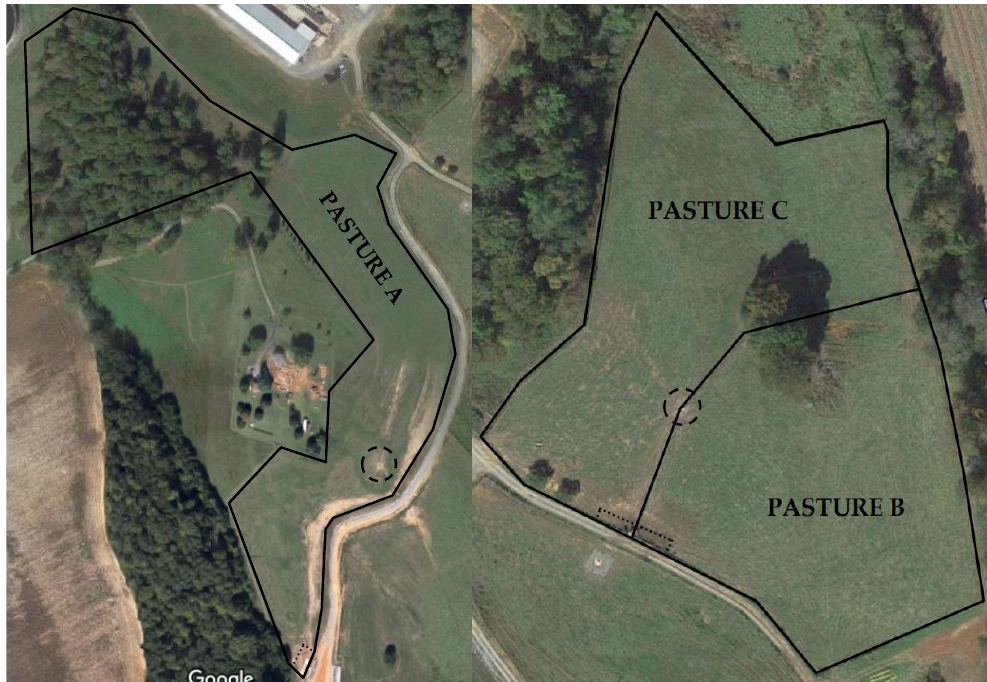
Figure 2. Aerial view of paddocks at University of Tennessee’s Little River Research and Environmental Unit. Cows were managed in Pasture A from August to September 2013 and Pastures B and C from September 2013 to January 2014. Water locations are denoted by a dashed circle and feedbunk locations are denoted by dotted lines. Aerial images obtained through Google Maps (Google, Moutain View, CA, USA).